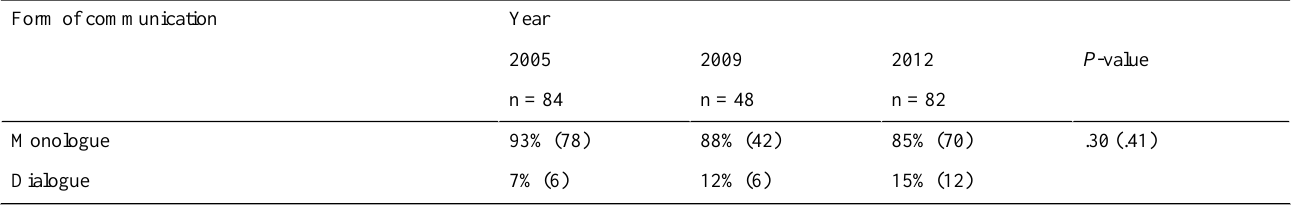
Table 3. The share of search hits on Google on the search term suicide distributed on the variable Form of communication. In percent (and frequencies). P -values based on Fisher’s exact test for association (and Cochran-Armitage trend statistic in parentheses).